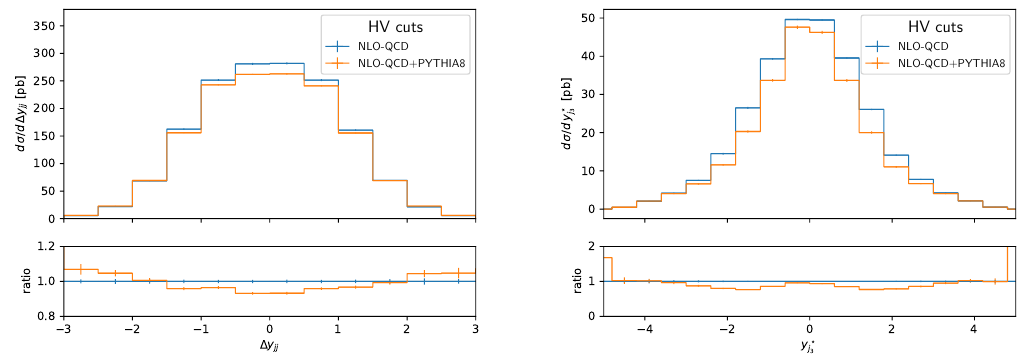
variable of the third-hardest jet 3